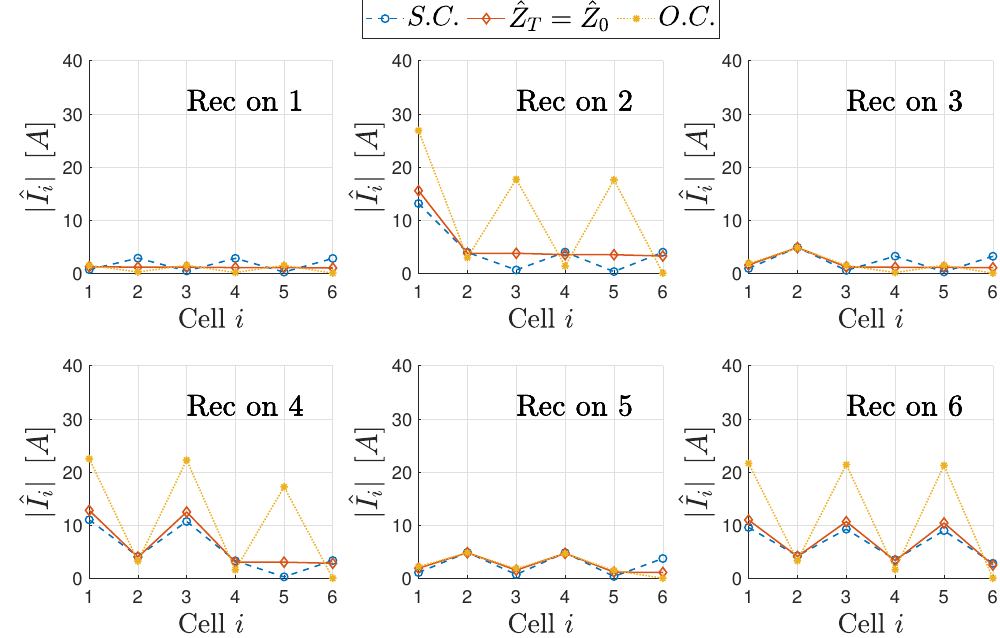
Figure 17. Standing wave patterns for different positions of the receiver, different terminations and a receiver load ˆ Z load = 5 Ω